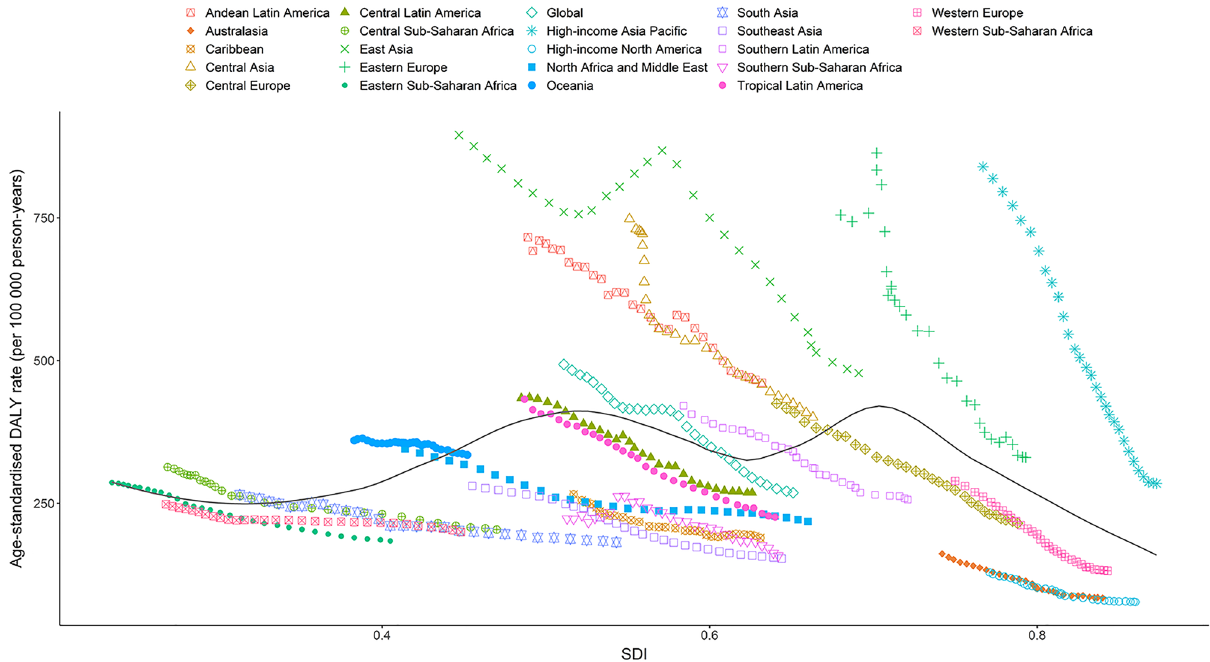
Figure 5. Age-standardized DALY rates for stomach cancer for 21 Global Burden of Disease region by SDI, 1990–2019. Black line represents the expected age-standardized DALY rates of stomach cancer based solely on SDI. For each region, points from the left to right depict estimates from each year from 1990 to 2019. SDI Socio- demographic Index, DALY disability adjusted life